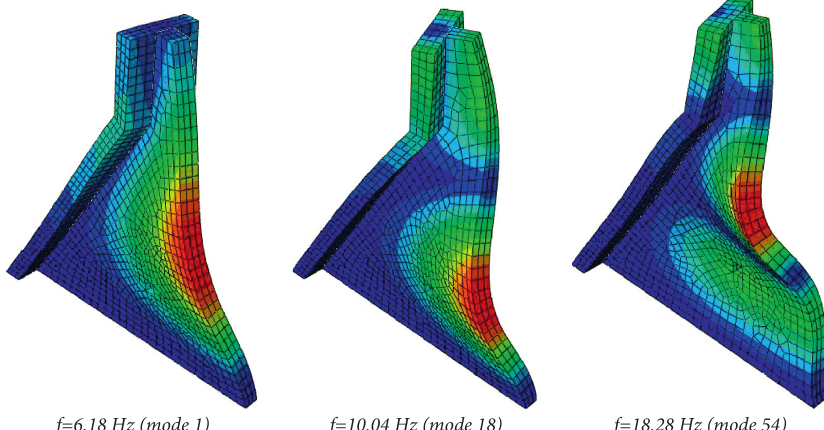
Figure 8: Lateral bending mode shapes of the middle monolith. (a) f � 6.18 Hz (mode 1), (b) f � 10.04Hz (mode 18), and (c) f � 18.28Hz (mode